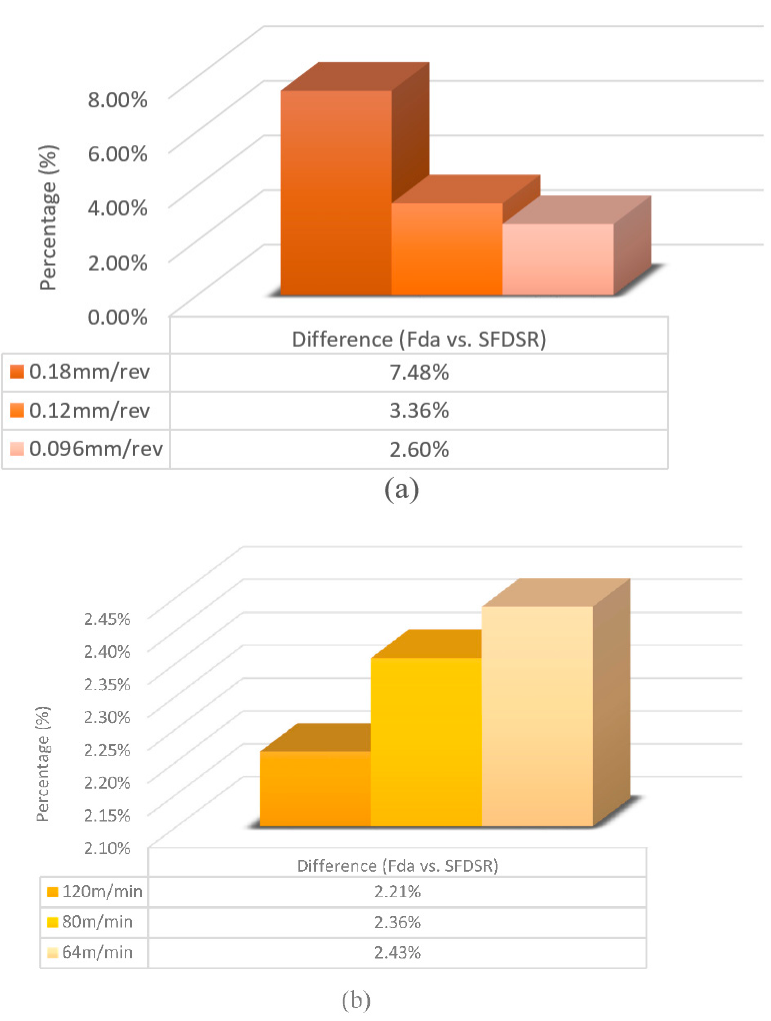
Figure 10. Difference (%) between both the delamination factors at: ( a ) a constant cutting speed; ( b ) a constant feed rate. Difference (%) = (S FDSR − F da / S FDSR ) × 100